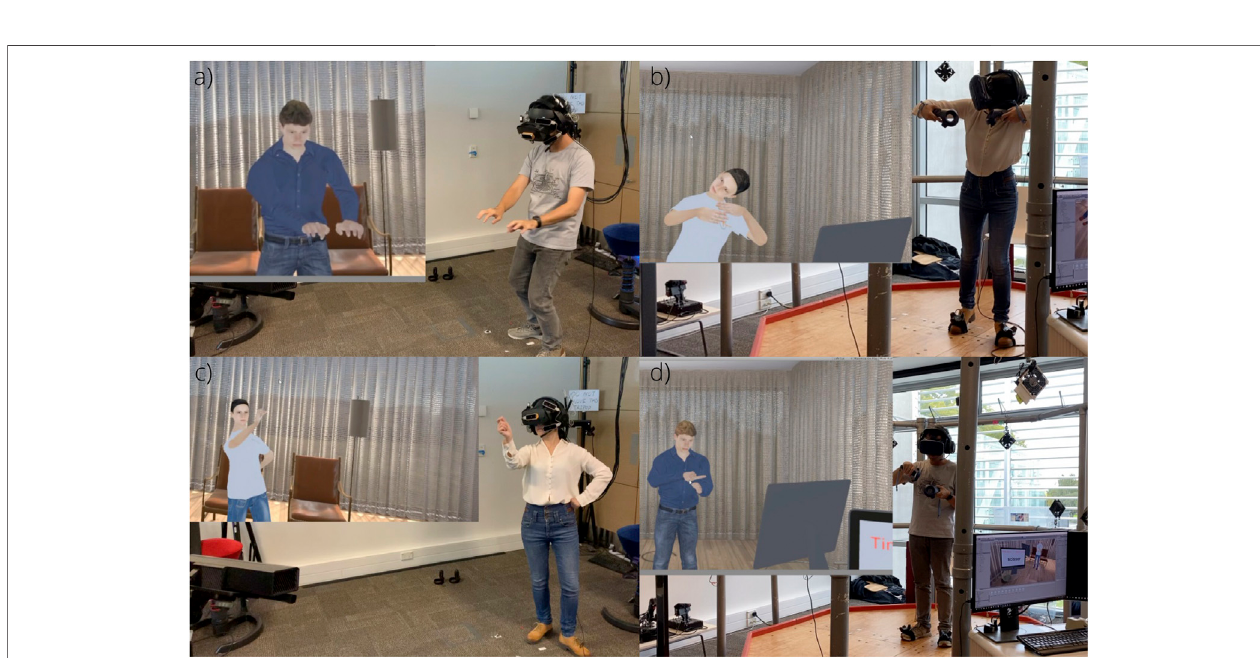
FIGURE 5 | The experiment process. (A) Session 1, word performer using HEA control, (B) Session 2, word performer using LEA control, (C) Session 3, word performer using HEA control, and (D) Session 4, word performer using LEA control.